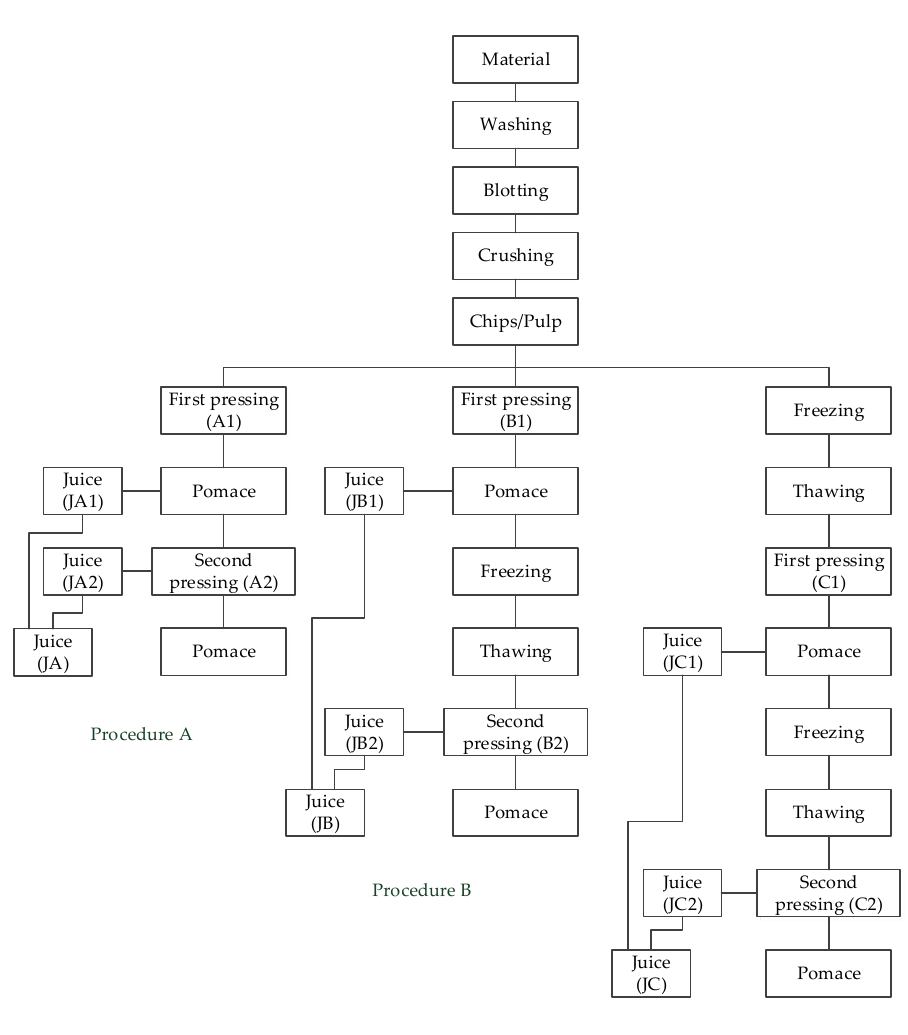
Figure 2. Experiment scheme: JA1—juice obtained in procedure A after first pressing; JA2—juice